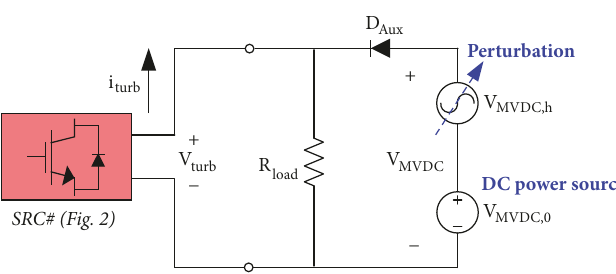
Figure 15: Configuration of laboratory test bench(V